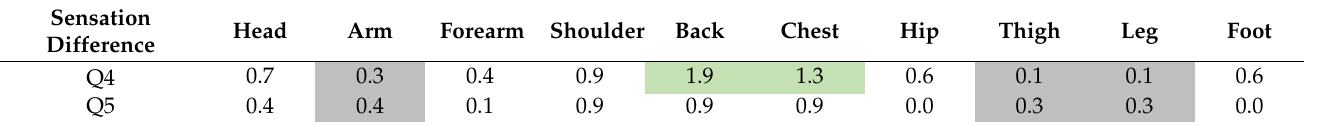
Table 10. Difference between thermal sensation level and neutral sensation level at Q4 and Q5 for the neutral group.